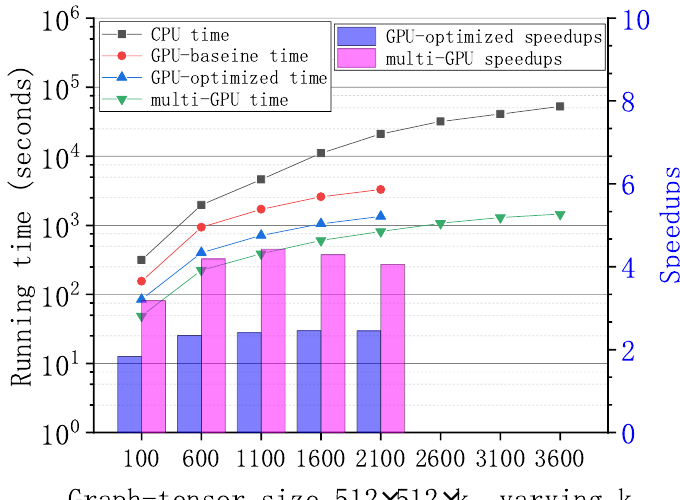
Figure 8. Running time of the GPU-base baseline, optimized, and multi-GPU implementations and the CPU MATLAB implementation with large-scale synthetic graph-tensors of 512 × 512 × k . Speedups of the GPU-optimized and multi-GPU implementations correspondingly. Graph-tensors of 512 × 512 × 2600 and larger exceed the capability of a single GPU. Table 2. Running time breakdown for a graph-tensor of 64 × 64 × 2100 using nvprof. Total GPU Algorithm